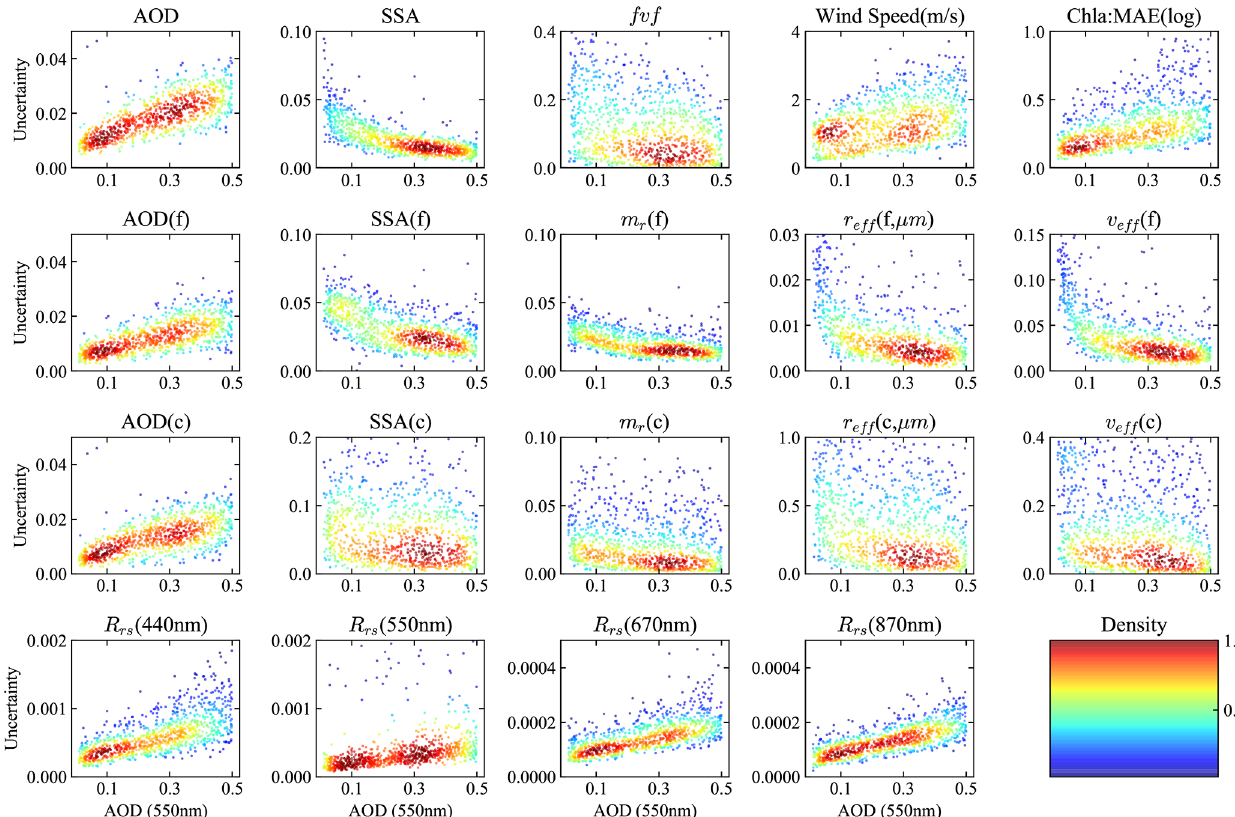
Figure 5. Theoretical retrieval uncertainties estimated from error propagation plotted against the AOD at 550nm (horizontal axis) for AOD, SSA, fine-mode volume fraction (fvf), refractive index ( m r ), effective radius ( r eff ) and variance ( v eff ), wind speed, Chl a in log 10 scale, and remote sensing reflectance ( R rs ). Synthetic HARP2 measurements are used in these retrievals. Colors indicate the relative density of the dots in the